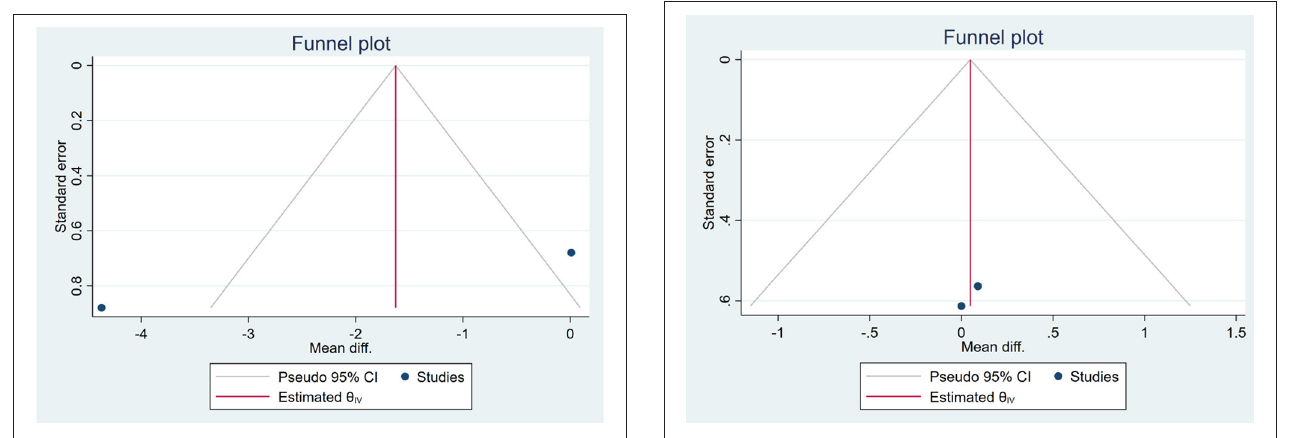
FIGURE 22 | Funnel plots of the effect of FINS.